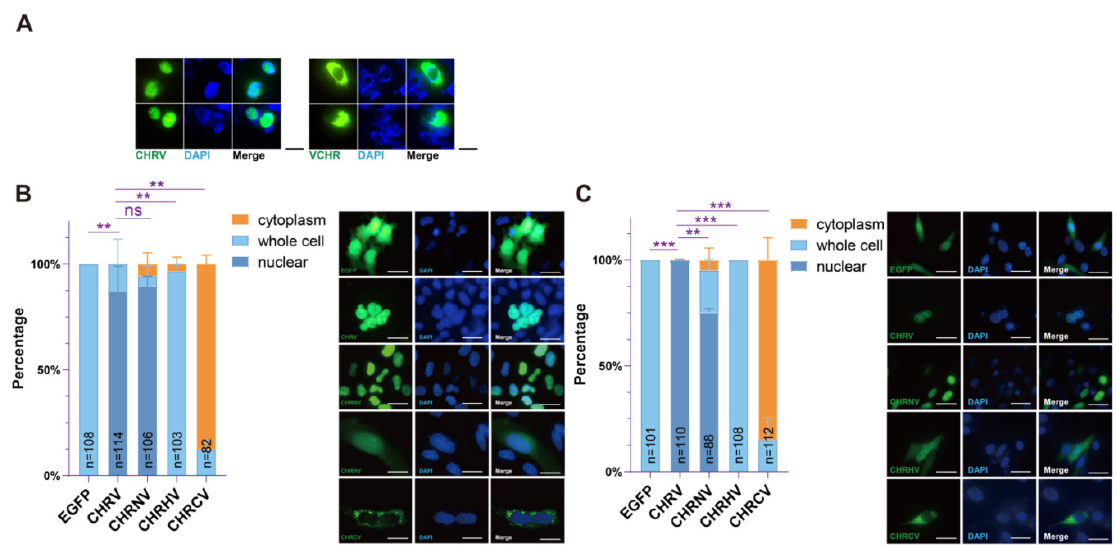
Figure 6. N-terminus of CHR is required for its nuclear localization. ( A ) Localizations of CHRV (CHR-cpVenus, cpVenus on the C-terminus of CHR) and VCHR (cpVenus-CHR, cpVenus on the N-terminus of CHR) in U2-OS cell line. CHRV is mainly localized in the nuclei, while VCHR mainly stayed in the cytoplasm. Bar = 30 μ m. ( B ) Different CHR constructs were expressed (right) to study their cellular localizations in Hela cells and analyzed in histogram (left). The nuclear distributions were statistically analyzed with two tailed unpaired t-test. ns, non-significance; ** p< 0.01. *** p< 0.001. Bar = 30 μ m. ( C ) Different CHR constructs were expressed to study their cellular distributions in NIH 3T3 cells (right) and their cellular distributions were statistically analyzed in histogram (left). The nuclear distributions were statistically analyzed with two tailed unpaired t-test. ** p < 0.01. *** p < 0.001. Bar = 30 µ m. CHRV was used as a control to show the nuclear localization of CHR,